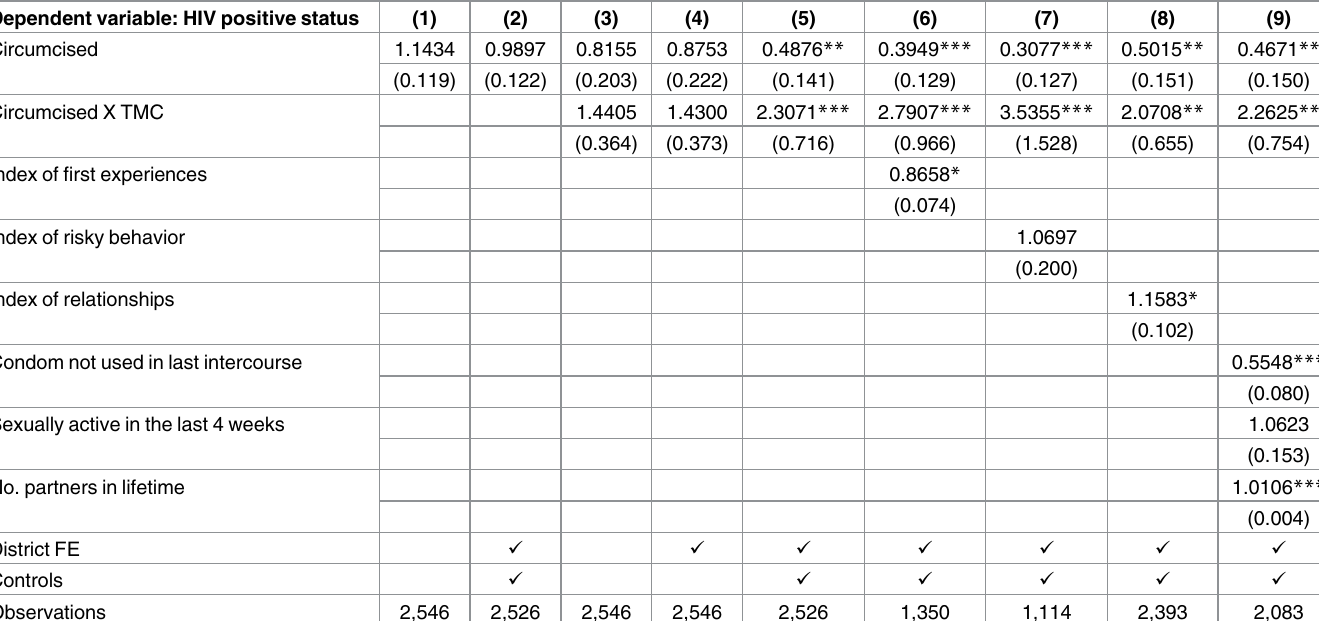
Table 4. Male circumcision and HIV